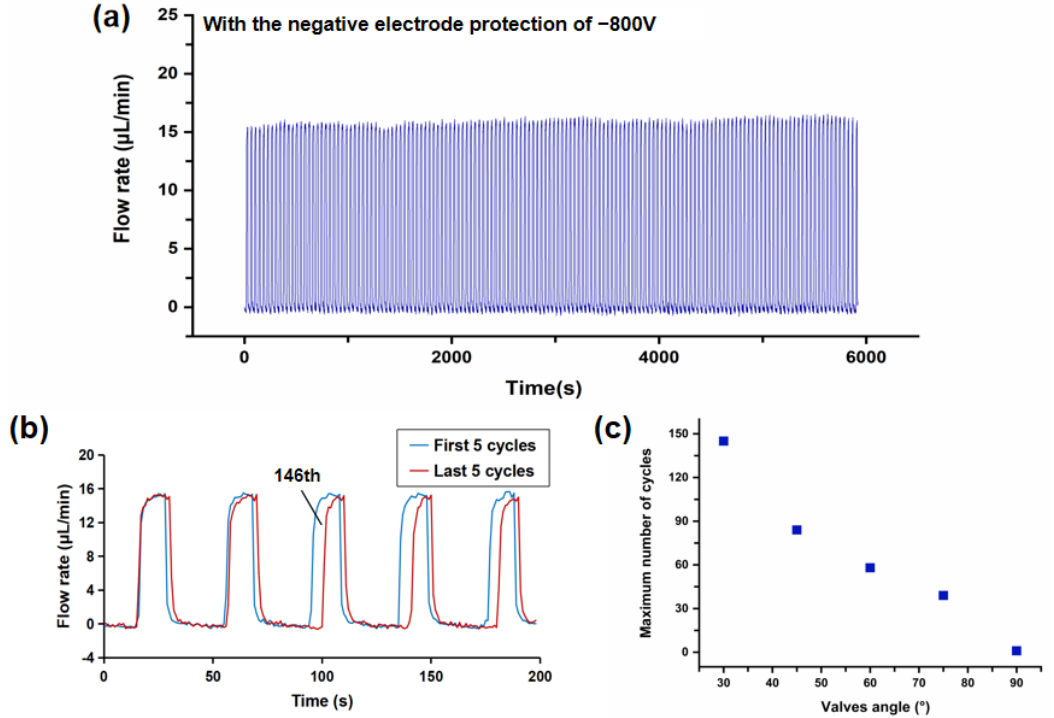
Figure 5. Repeatability test of microvalves. ( a ) Cycle switching tests for the valve and amplification curve for last 5 cycles. ( b ) The comparion of the first 5 cycles and the last 5 cycles. ( c ) Maximum number of cycles for different valve angles.